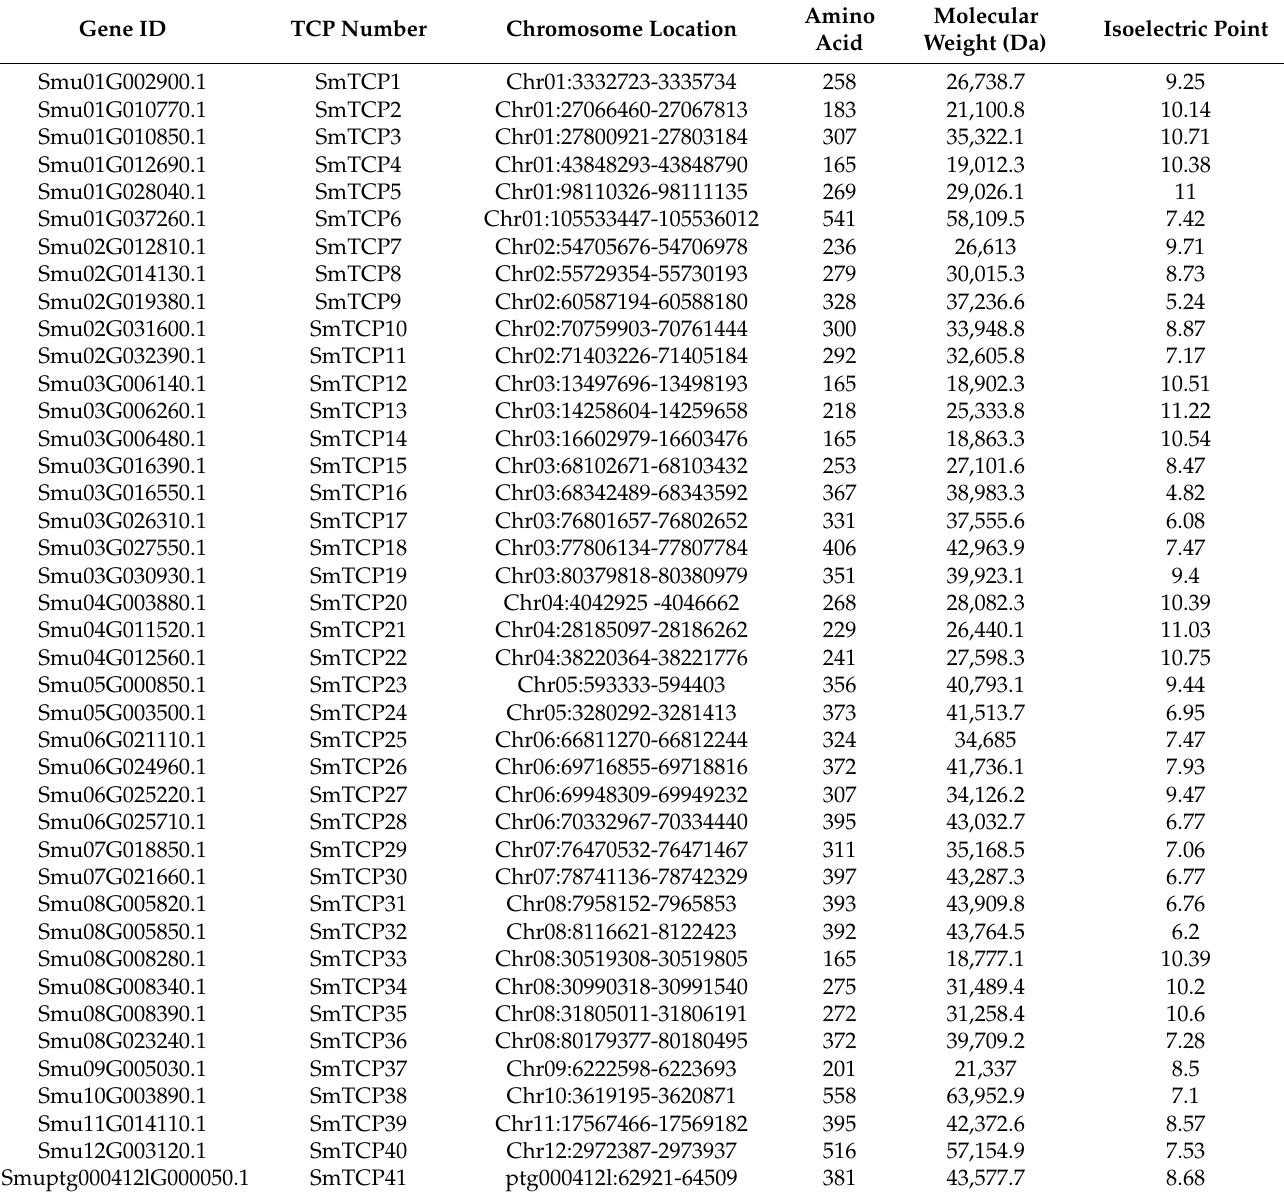
Table 1. Information on members of TCP transcription factor family in S. muricatum